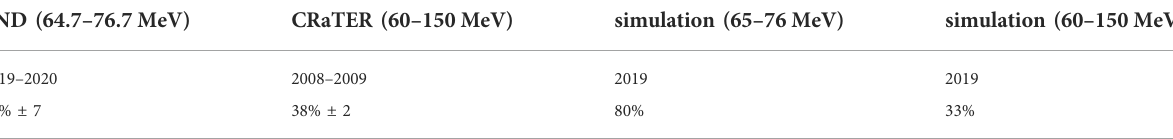
TABLE 1 The ratio of lunar albedo protons to primary